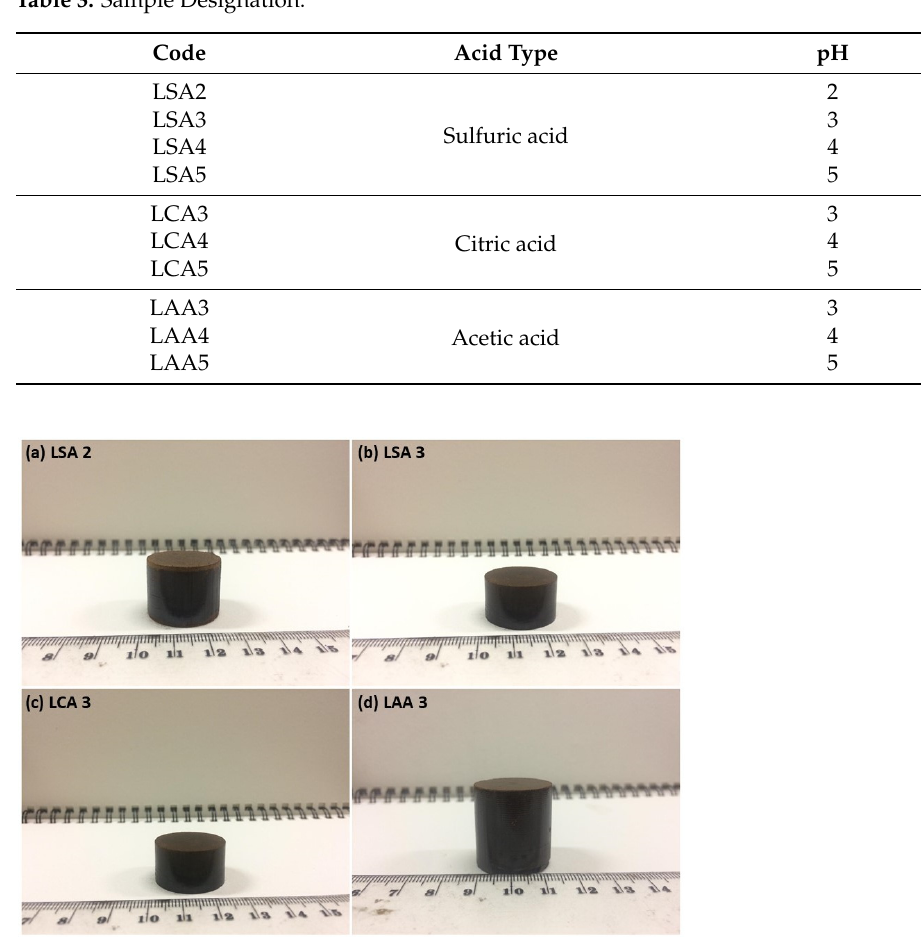
Figure 12. Lignin briquette of ( a ) LSA2, ( b ) LSA3, ( c ) LCA3, and ( d ) LAA3.